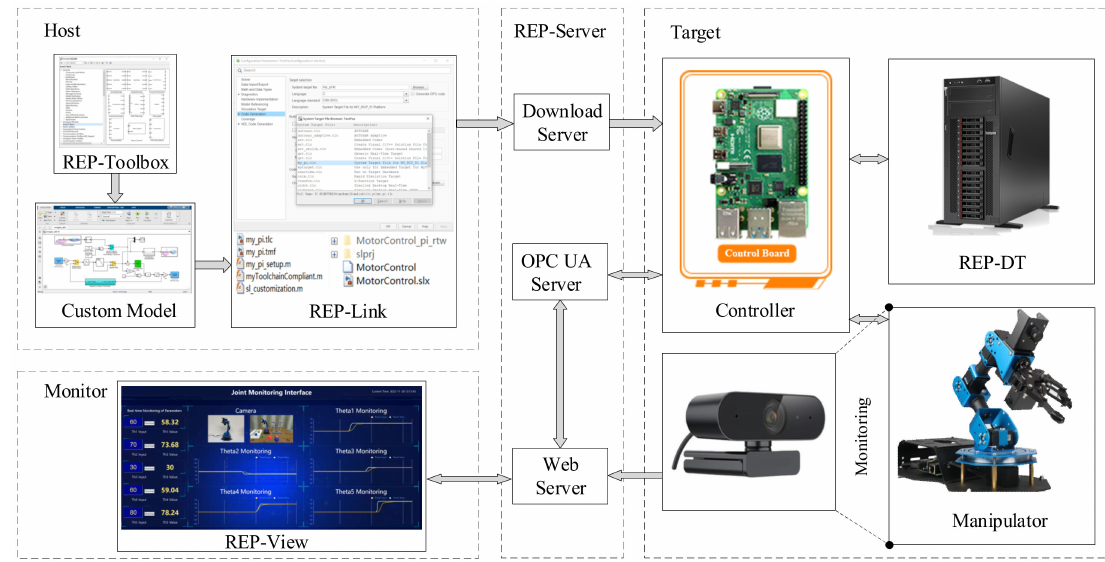
Figure 1. System diagram of the experiment